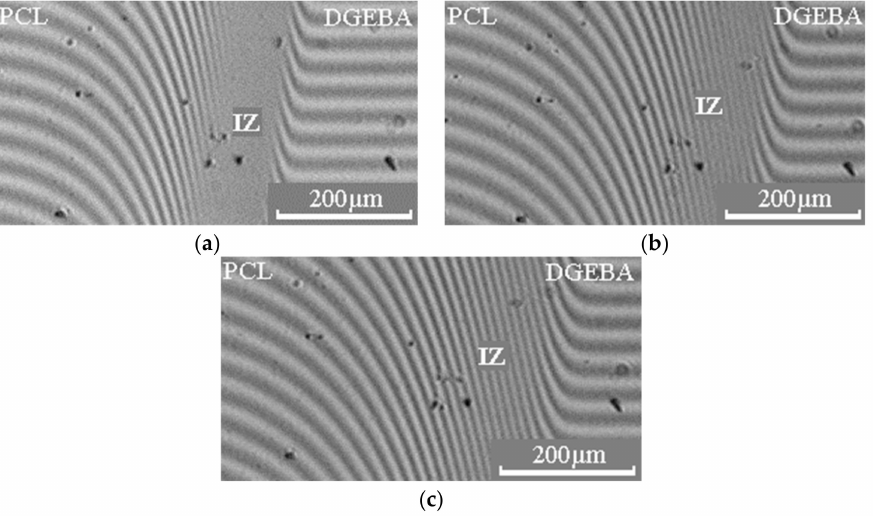
Figure 9. Interferograms of the interdiffusion zone of the PCL (M n = 45 × 10 3 ) – DGEBA system, obtained at a temperature of 80 ◦ C for ( a ) 16; ( b ) 25; ( c ) 36